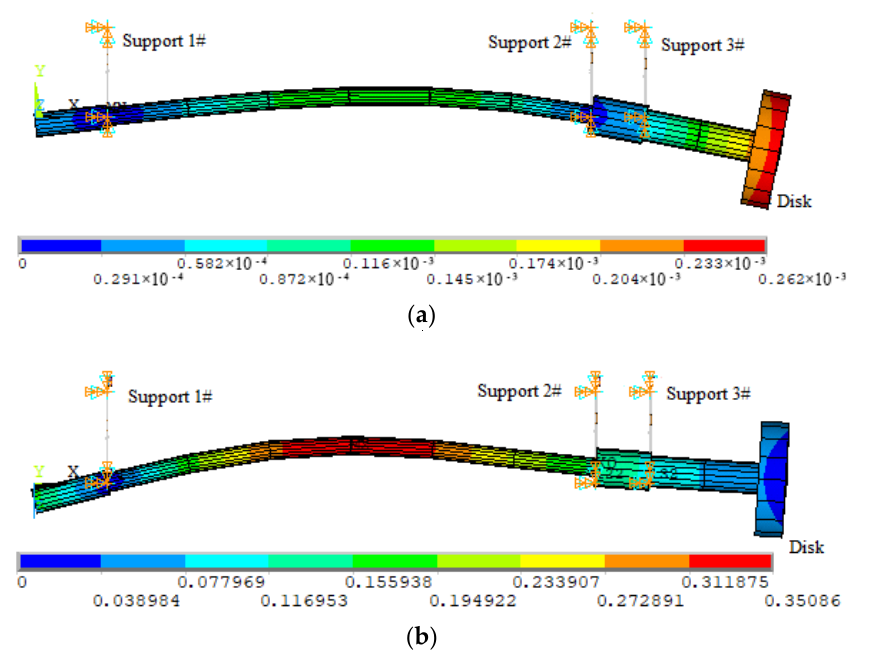
Figure 19. Natural vibration modes of the derived linear rotor system: ( a ) the first mode; ( b ) the second mode.